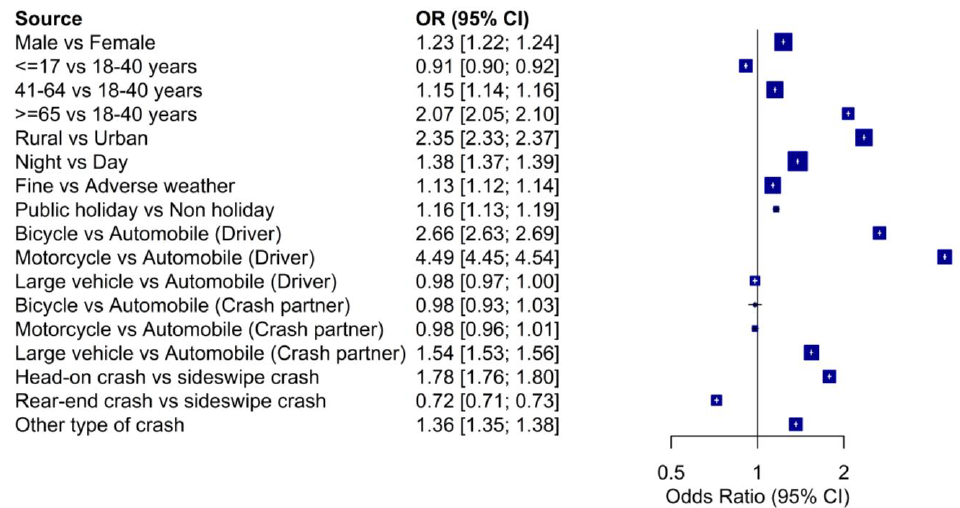
Figure A4. Forest plot of multiple logistic regression result for each independent variables using the UK STATS19 data [24].